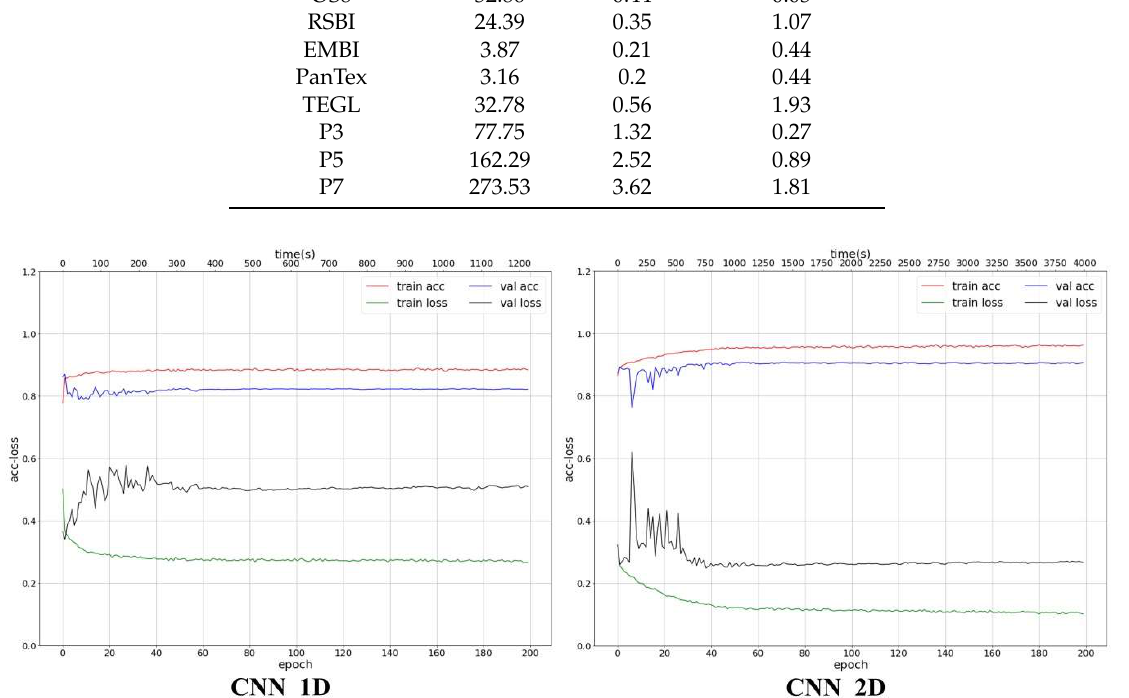
Figure 11. The training process of the CNN_1D and CNN_2D (training time: s).